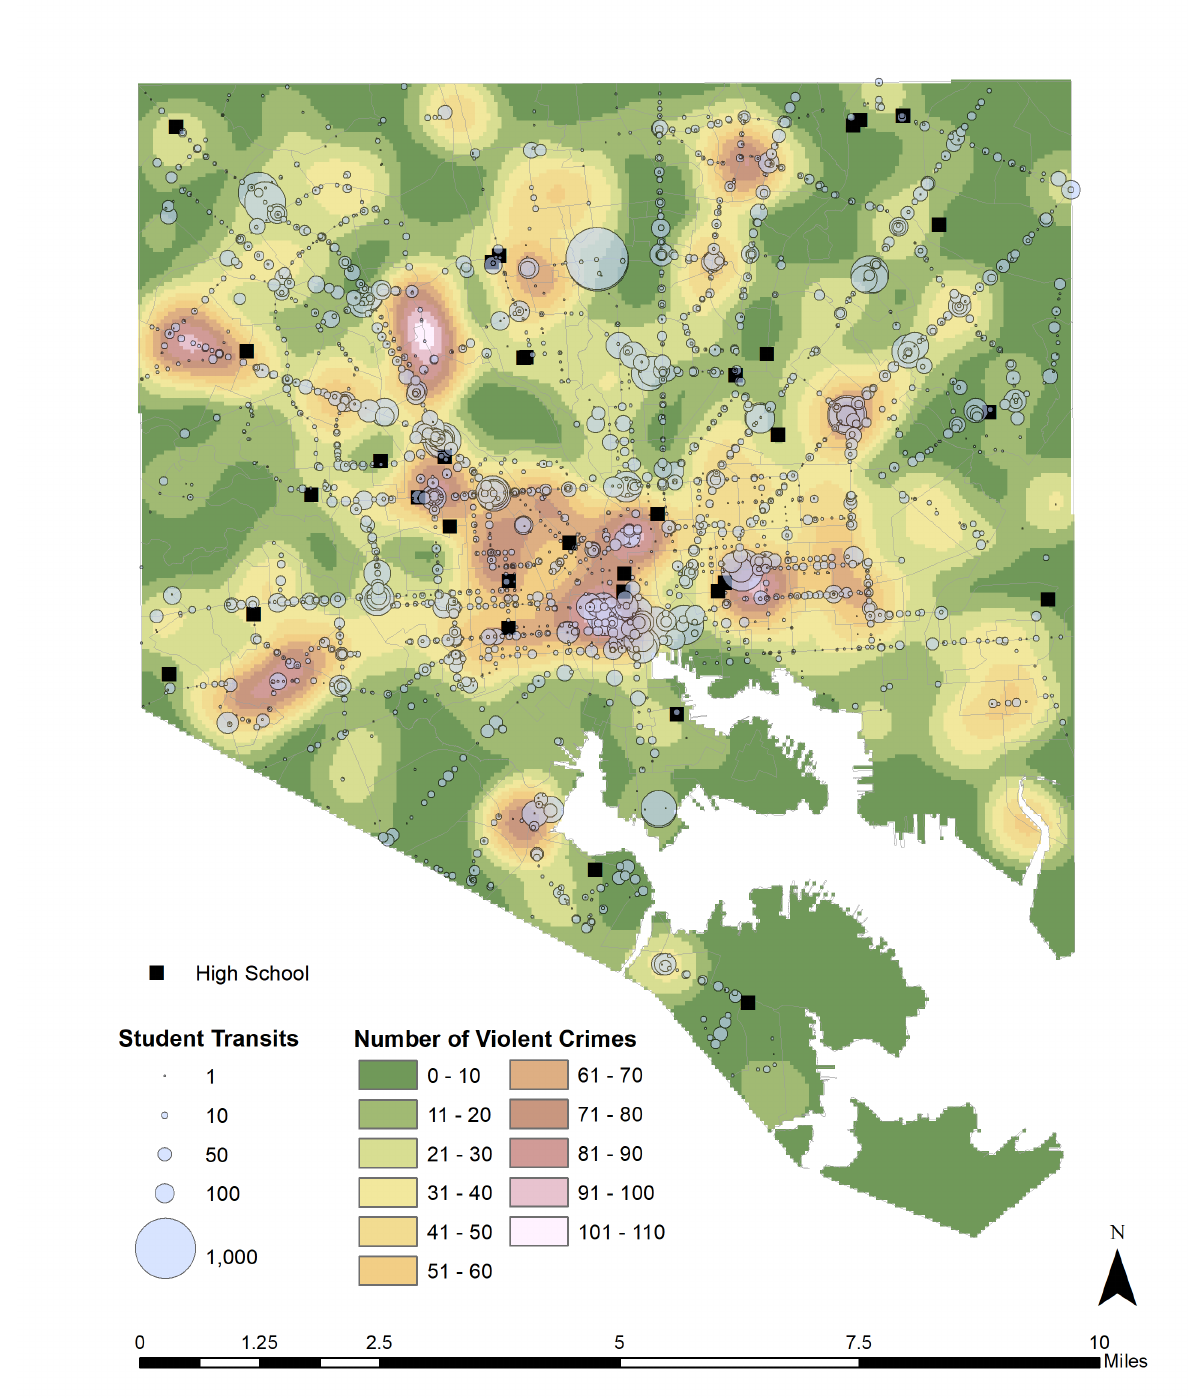
Figure 3: Transit stops by volume of student usage and number of violent crimes (2014–2015 academic year). Source : Authors’ calculation is based on data from the Baltimore Police Department, the Maryland Transit Administration, and the Baltimore City Public